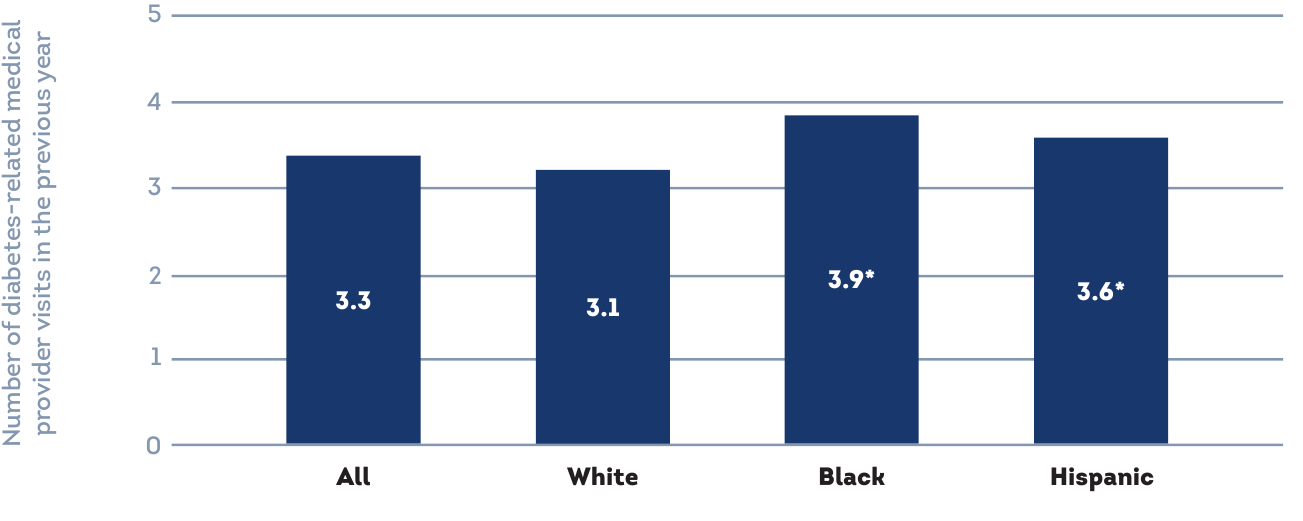
Figure 6. Average number of diabetes-related medical provider visits in the previous year, among community-dwelling Medicare beneficiaries with self-reported diagnosed diabetes, by race/ethnicity